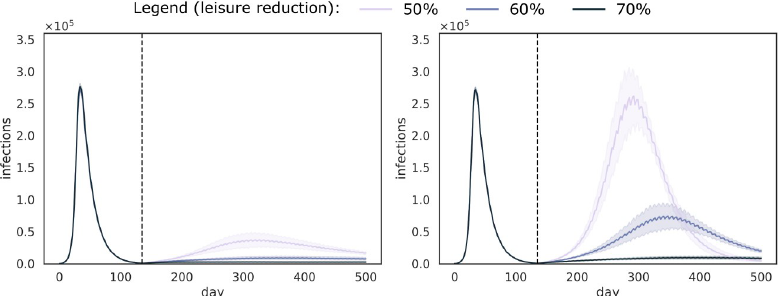
Fig 6. Trends for different leisure contact reductions, when performing weekly universal testing, and importing 50 cases per day. We assume that universal testing starts (and lock-down ends) on the first of July, as marked by the vertical dotted line, and that FNR PCR = 0.1. We consider both isolation strategies: pool isolation (left panel) and individual isolation (right panel). The curves show a line that depicts the average over the trajectories of the result aggregations and a shaded area that depicts the standard